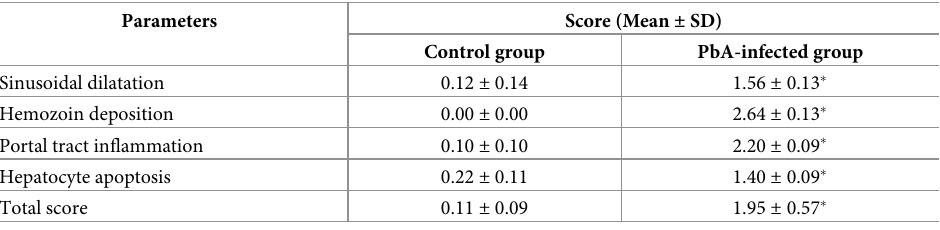
Table 3. Mean scores of four main histological features in tissues from the control (n = 10) and PbA-infected groups (n = 10).